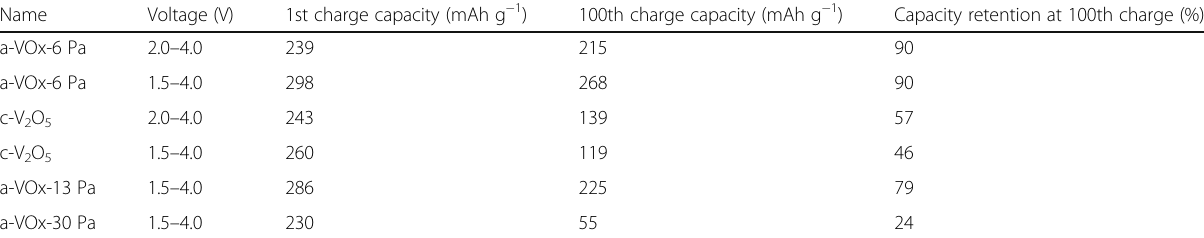
Additional file 1: Figure S15. The absence of the intercal- ation features confirms the complete amorphous nature in tune with the XRD inferences. The observed GC charge- discharge profiles obtained after mitigating substrate effect (Fig. 4b, d) are consistent with CV results. A small char-